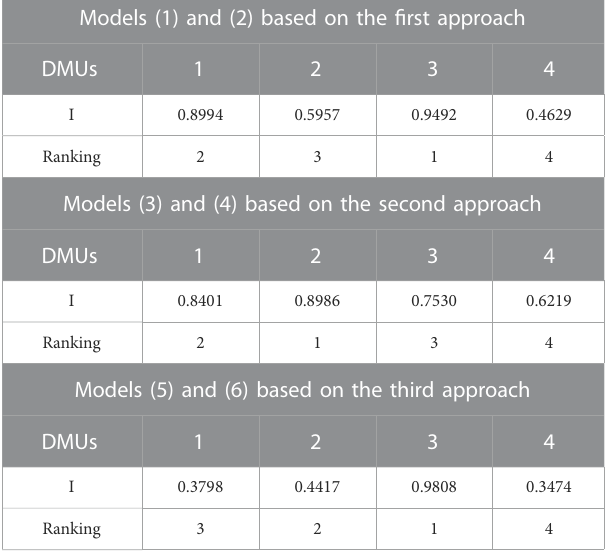
TABLE 10 The ranking results of DMUs according to the models. Models (1) and (2) based on the fi rst approach